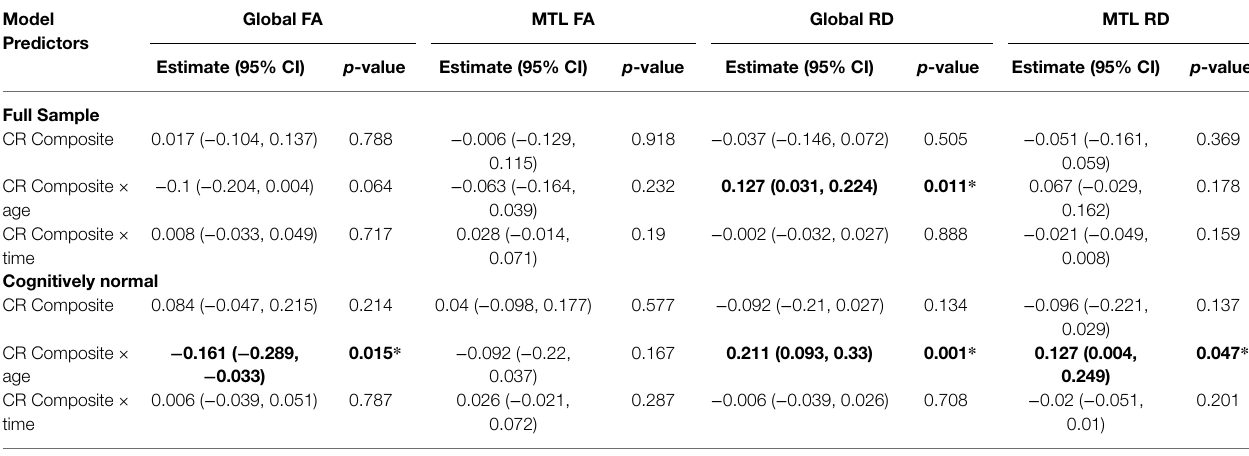
TABLE 2 | Results of the reduced longitudinal mixed effects models examining whether the relationship between the CR composite score and white matter microstructure differs by baseline age (see text for